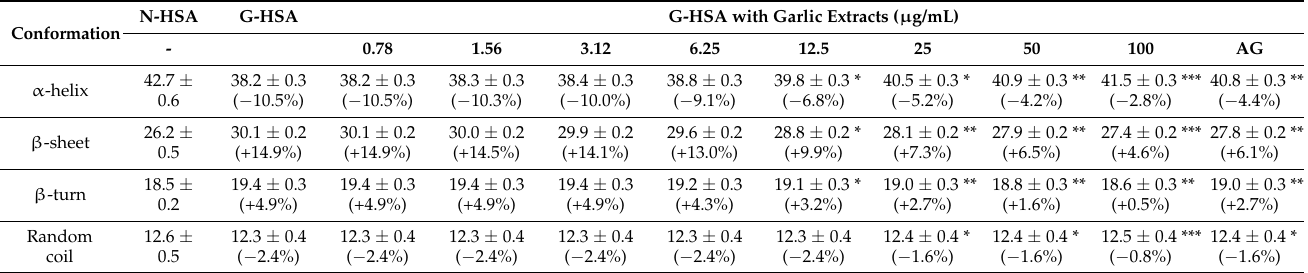
Table 2. Secondary structure composition of N-HSA, G-HSA, and G-HSA incubated with different concentrations of garlic extract (0–100 µ